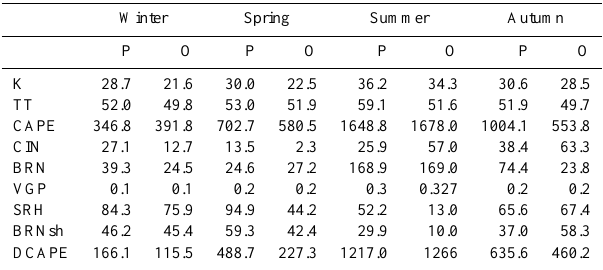
Table 2. Mean seasonal index values for the potentially (P) and observed (O) extreme weather Fig. 2. The distribution of the values of the CAPE index for the days where extreme (right) and non-extreme (left) events occurred.